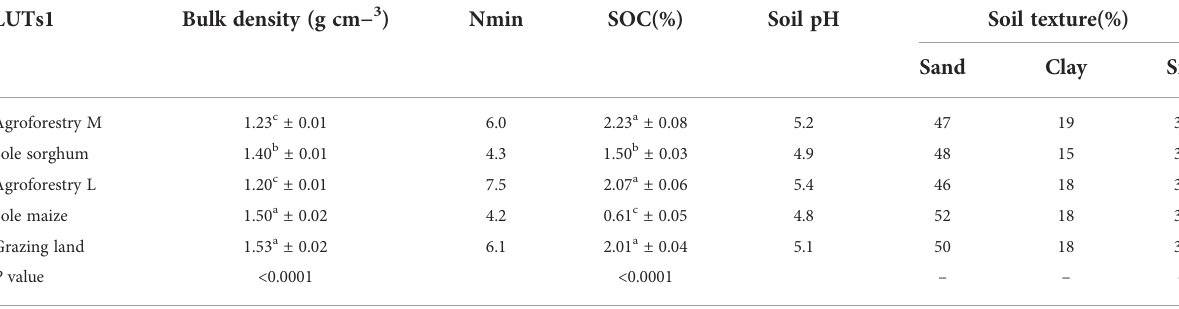
TABLE 2 Baseline soil properties under different land utilization types at 0 – 20 cm depth in Siaya County, Kenya.